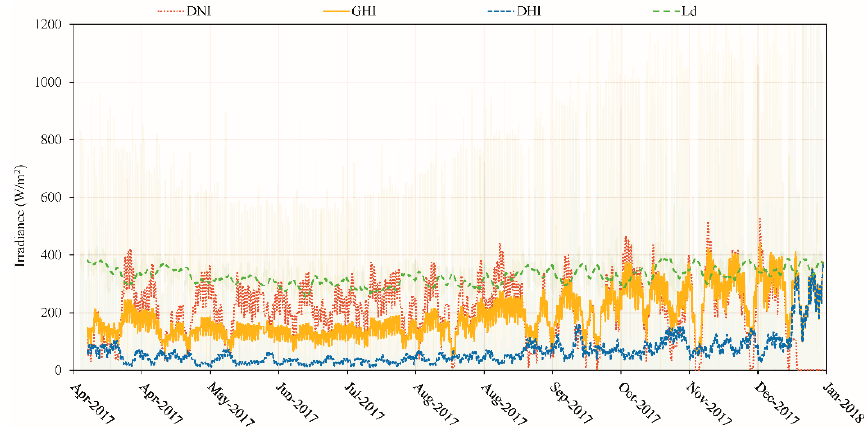
Figure 4. Various components of the solar radiation distribution.